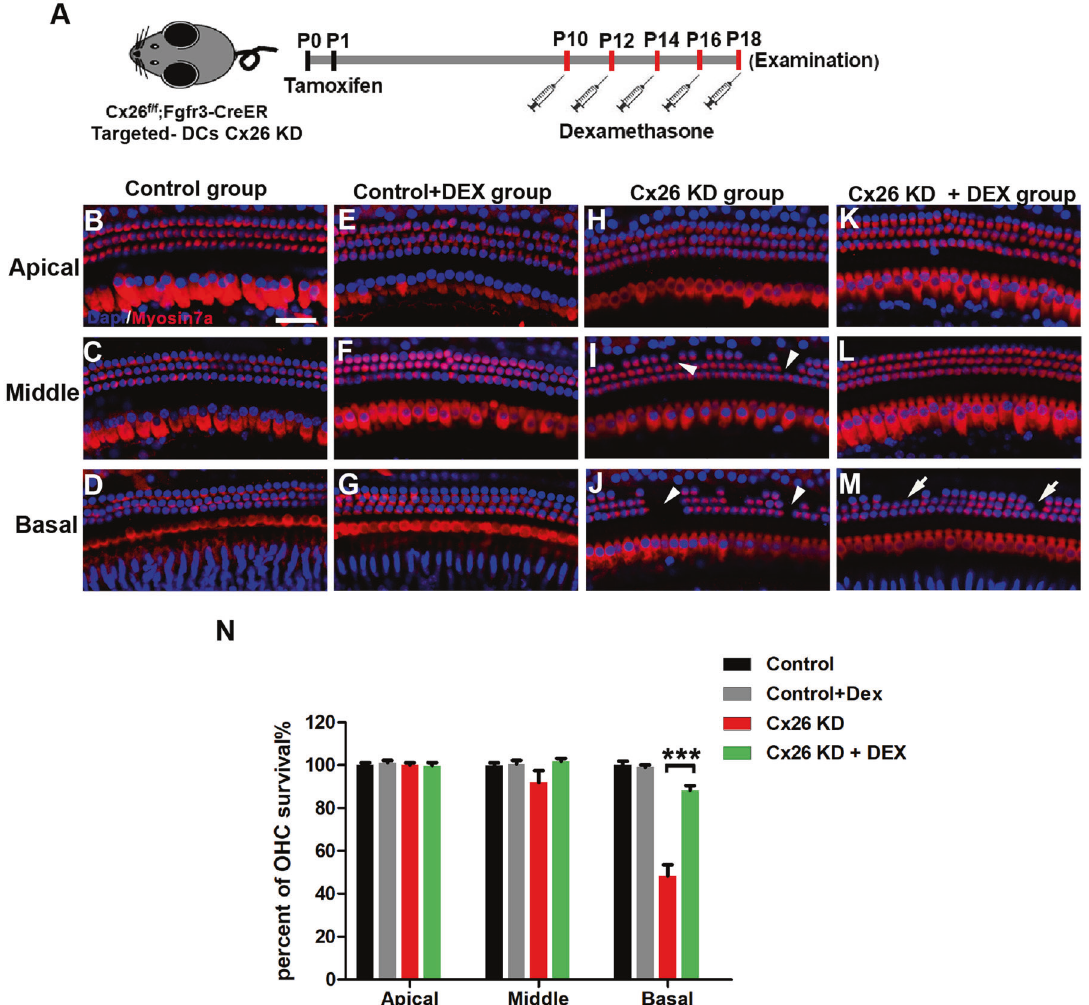
Fig. 5 Effects of dexamethasone on the degeneration of outer hair cell in DC-targeted Cx26-null mice. A Schematic of the experimental work fl ow, Cx26 f/f ; Fgfr3-CreER mice were injected with TMX and then treated with dexamethasone 5 mg /kg of body weight for fi ve days. B – M Immuno fl uorescence staining with myosin 7a (red) and DAPI (blue) in different turns of the cochleae from different group. Representative images of the control group ( B – D ), control + DEX ( E – G ), Cx26 -null ( H – J ), and Cx26-null + DEX group ( K – M ) are shown. The White arrowheads in panels H – J indicate the miss of hair cells. N Quanti fi cation of the survival rate of OHCs in different treatment group. n = 5 mice in each group, *** P < 0.001. Scale in panel ( B ) represents for 40 μ